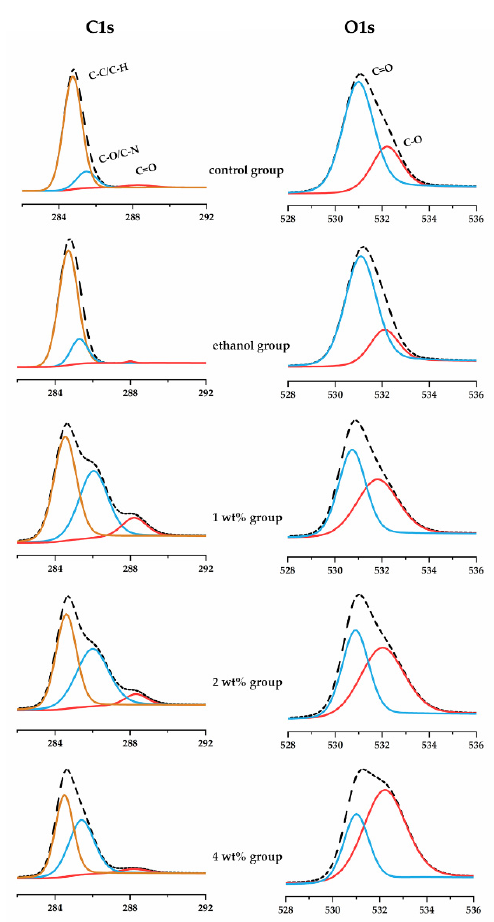
Figure 5. XPS high-resolution C1s (left column) and O1s (right column) spectra of dentin treated by irrigants. Table 1. Data of C1s and O1s XPS narrow-scan spectra for dentin treated by